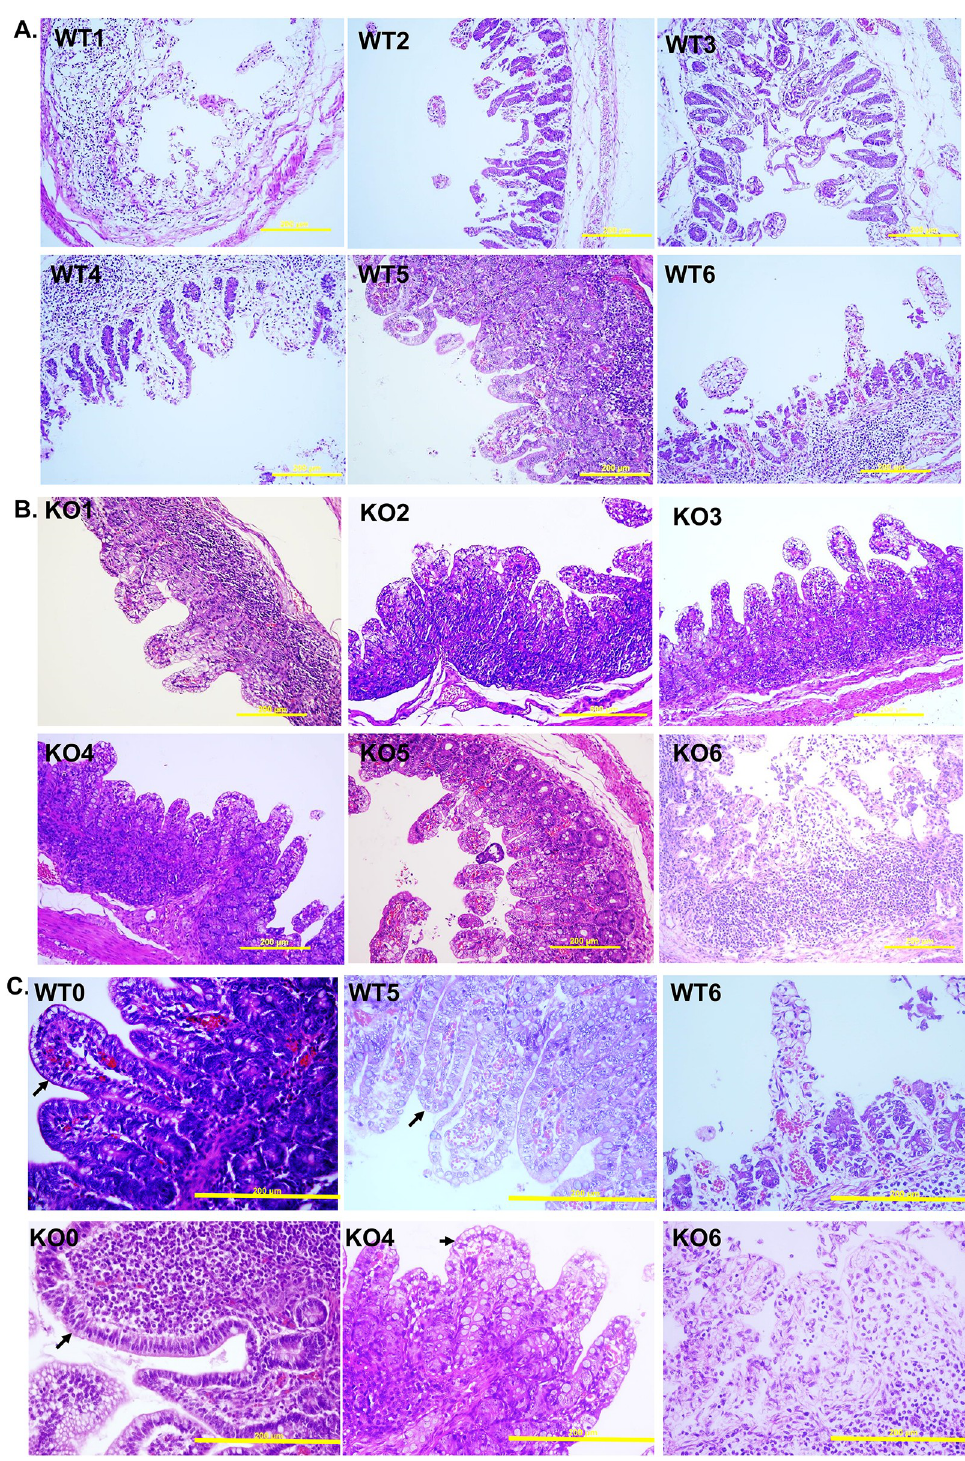
Fig 8. Pathological inspection of piglets’ intestine at the middle jejunum by H/E staining. Panels A. and B. indicate wild-type and knockout piglets, respectively, after PEDV oral inoculation. C. The samples from control, the best and the worst pathological responded piglets, which are no nv-PEDV-inoculated, survival and dead, respectively, at 72 hpi. The upper panels (WT0, WT5 and WT6) are samples from wild type piglets and the down panels (KO0, KO4 and KO6 are samples from CMAH KO piglets. Arrows indicate epithelial cells and the yellow bars indicate 200 μ m.